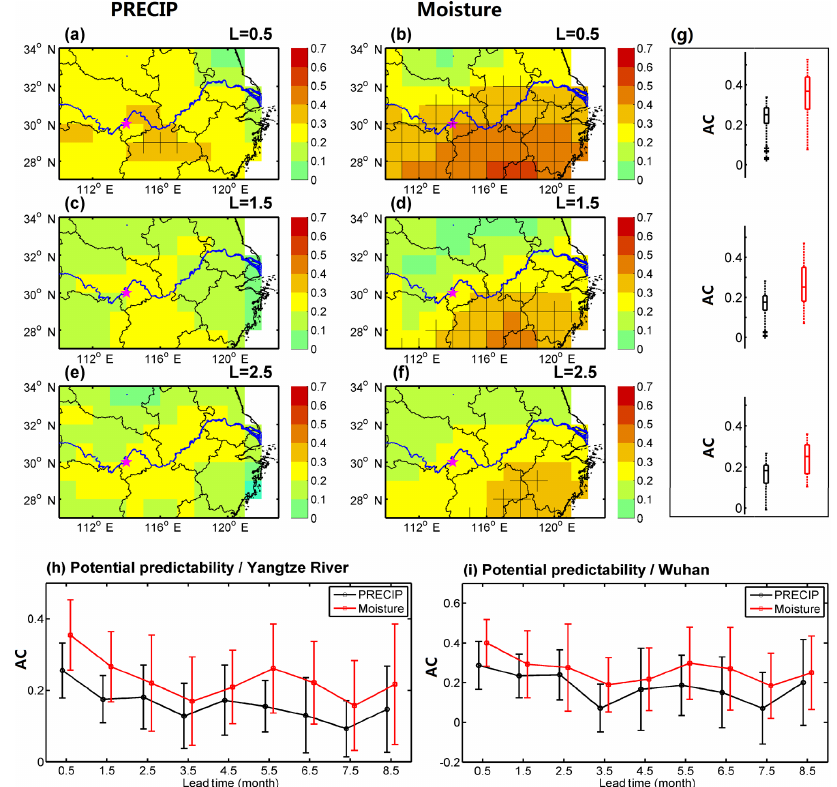
Figure 4. (a–f) Potential predictability (AC value; see “Method”) for June–July mean precipitation and atmospheric moisture flux at different lead times during 1982–2016 over the middle and lower reaches of the Yangtze River for the 0.5-, 1.5-, and 2.5-month leads; the stippling indicates a 95% confidence level according to a two-tailed Student’s t -test. (g) Median, lower, and upper quartiles, 1.5 times the interquartile ranges for AC values for precipitation (black) and moisture (red) throughout the study region (110–123 ◦ E, 27–34 ◦ N); outliers are displayed with + signs. (h–i) Potential predictability throughout the study region and Wuhan (pink pentagram in a ) at different lead times; the error bars are standard deviations according to 24 members.